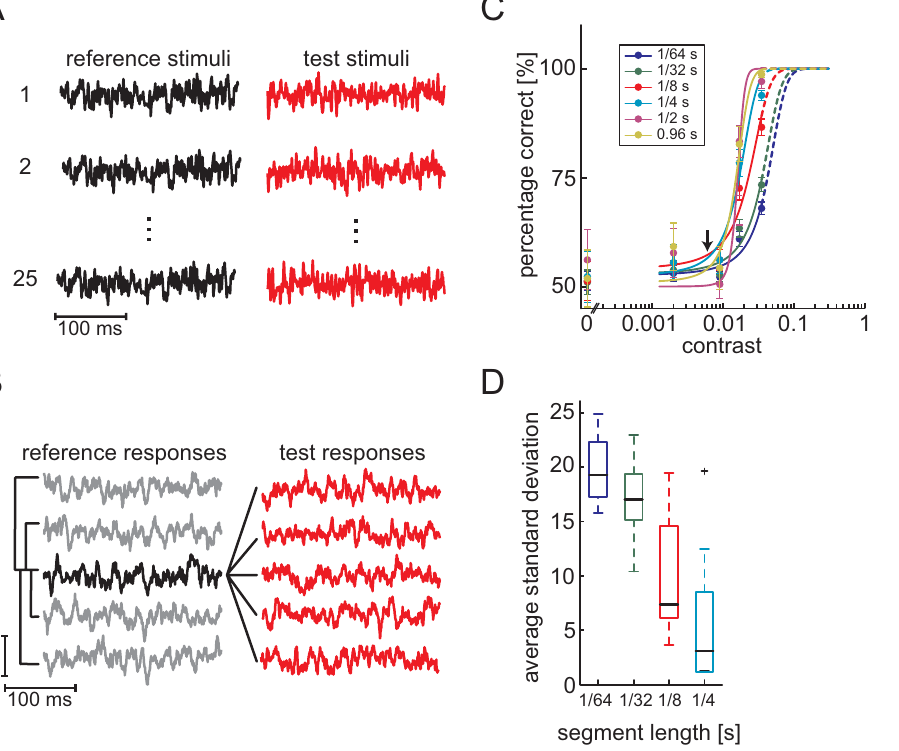
Figure 4. Signal-detection approach. A Experimental design for the discrimination task at one contrast level. Left hand column: the reference stimulus is repeated 25 times; right hand column: different test stimuli, all statistically equivalent to the reference stimulus. Reference and test stimuli of all five contrasts were presented in a pseudorandom order. B At each contrast level the two distances < D r > and < D t > were estimated according to equation 5 for each reference response (e.g. the highlighted one in the left box). C Response discriminability as a function of contrast. Dots mark the average discrimination performance (N=12) 6 SEM. Discrimination performances were calculated using data segments of different lengths (see legend). Data were fitted with a sigmoid function ranging from 50 to 100% (equation 6). The arrow marks the contrast which results from photon shot noise at the background light intensity. D Uncertainty of discriminability estimation for different segment lengths. For each cell, the discrimination performance was estimated for all possible data segments. The standard deviation of these discrimination performances was estimated. The box plots describe the distribution of these standard deviations in the cell population. Boxes indicate median (black line) and the upper, respectively lower quartile the whiskers represent the rest of the data. The plus-sign denotes an outlier. The two largest segment lengths used in C subdivided response traces only into one or two segments, thus no S.D. could be calculated.